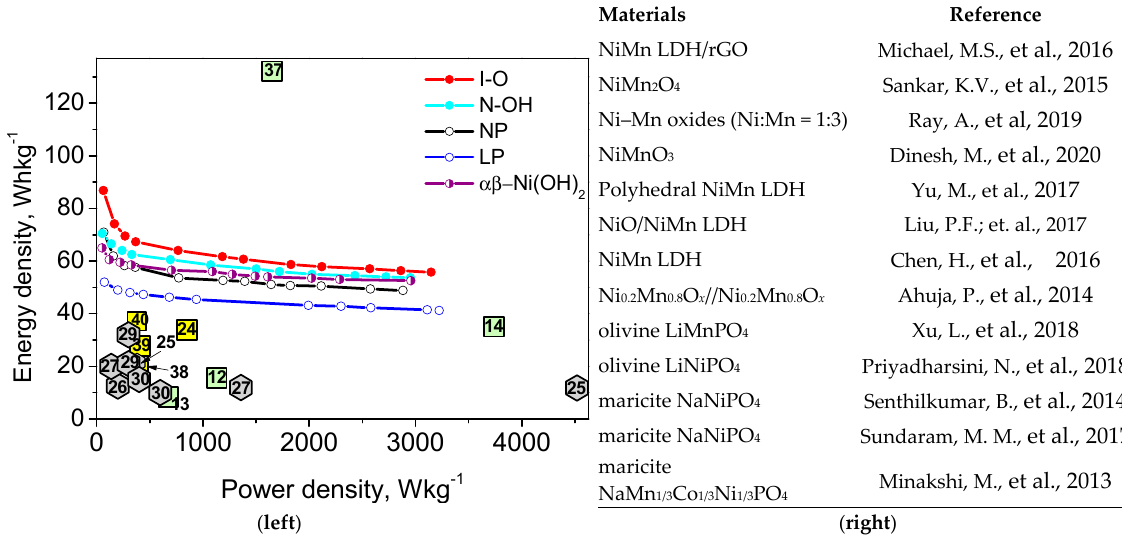
Figure 7. ( left ) Energy density versus power density (Ragone plot) for supercapacitors with different composite electrodes. The literature data for oxides, hydroxides and phosphates are indicated as , and , respectively ( right ). The used references are given in the figure: [12–14,24–27,29,30,37–40].